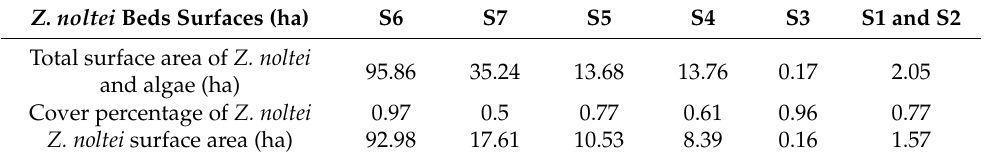
Table 6. Surface area for Z. noltei at each station in the Merja Zerga lagoon: S1, S2, S3, S4, S5, S6, S7. Z. noltei Beds Surfaces (ha) S6 S7 S5 S4 S3 S1 and S2 Total surface area of Z. noltei 95.86 35.24 and algae (ha) Cover percentage of Z. noltei 0.97 0.5 0.77 0.61 0.96 Z. noltei surface area (ha)